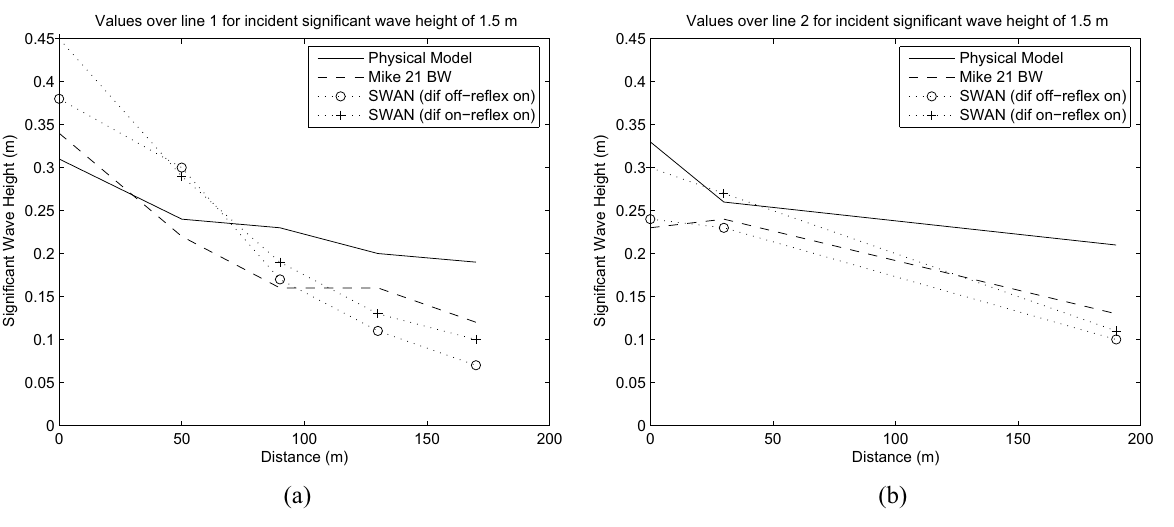
Fig. 3 – Significant wave height measured in the physical model and estimated by the models MIKE 21 BW and SWAN with reflection on for: diffraction off (dif off—reflex on) and diffraction on (dif on—reflex on). For incident significant wave height of 1.0 m (over Line 1 (a) and over Line 2 (b)).